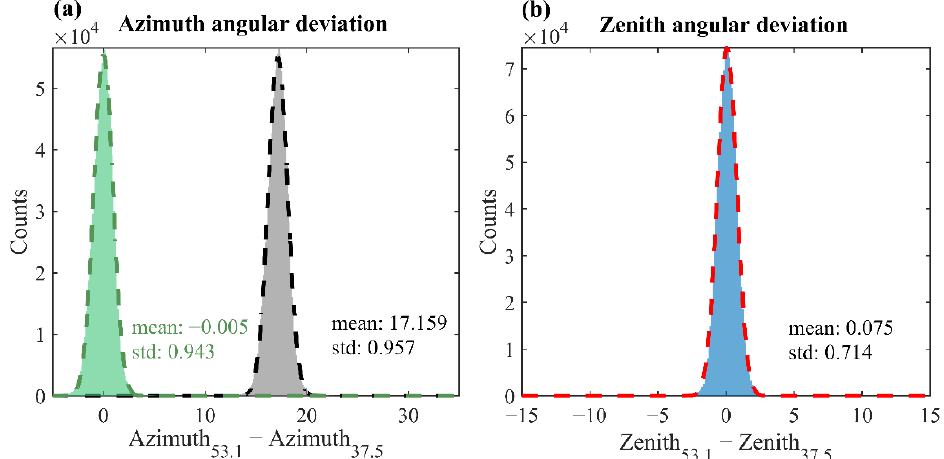
Figure 5. Histograms of the deviations in the ( a ) azimuth and ( b ) zenith reference directions for simultaneously observed meteor echoes. The dashed lines represent the best-fitting Gaussian curves. When the deviation from the azimuth reference direction between the two MRs is approximately 17 ◦ , the count of simultaneous meteor echoes reaches the maximum. The green and gray lines represent the statistical differences in the azimuth angles before and after the angular correction, respectively. The mean and standard deviation are also